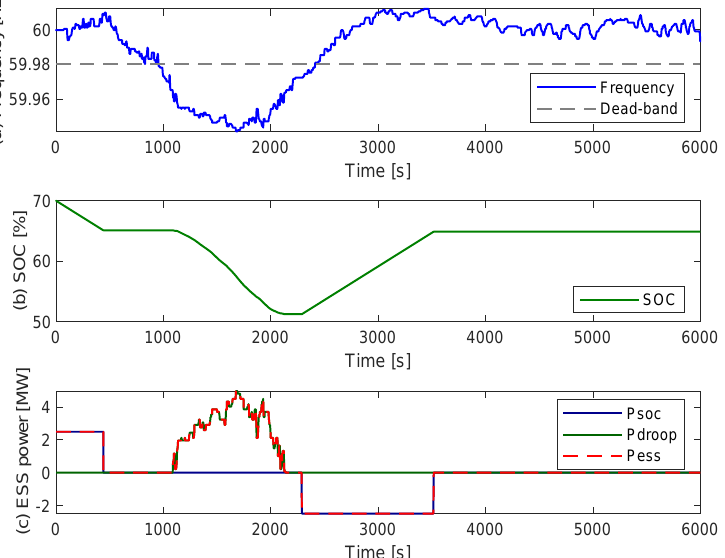
Figure 8. Example case of operation by influential factors (Freq. and SOC) to ESS output power: ( a ) Grid frequency, ( b ) SOC, ( c ) ESS